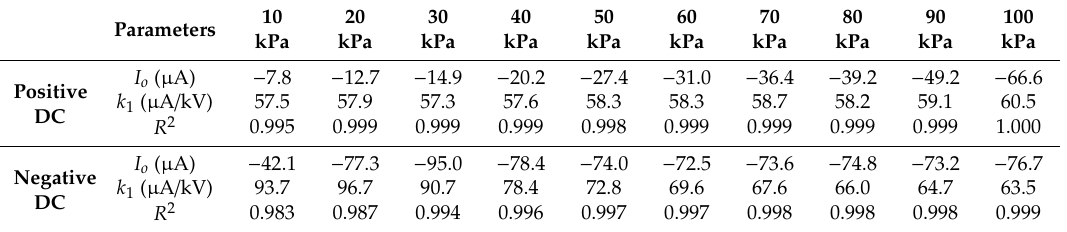
Table 1. DC supply. Main parameters of the linear regression between the leakage current and the applied voltage ( I leakage = I o + k 1 · V ).